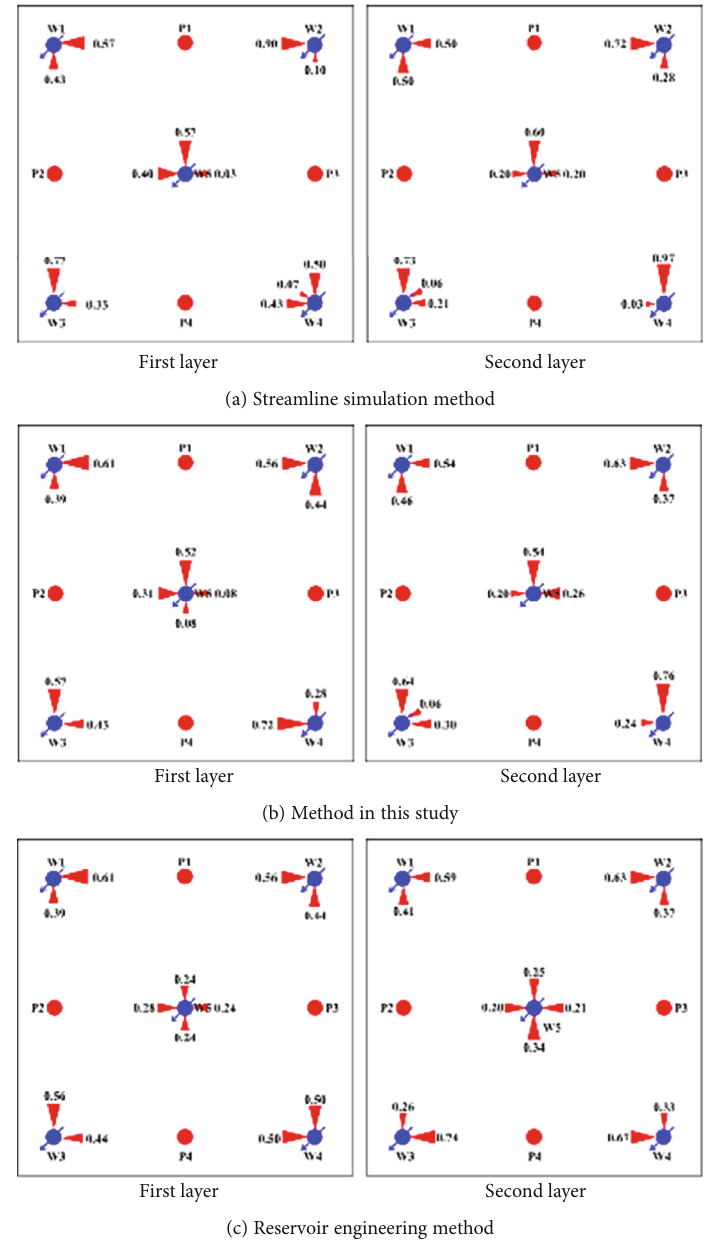
Figure 7: The plane dividing coe ffi cient of injectors in